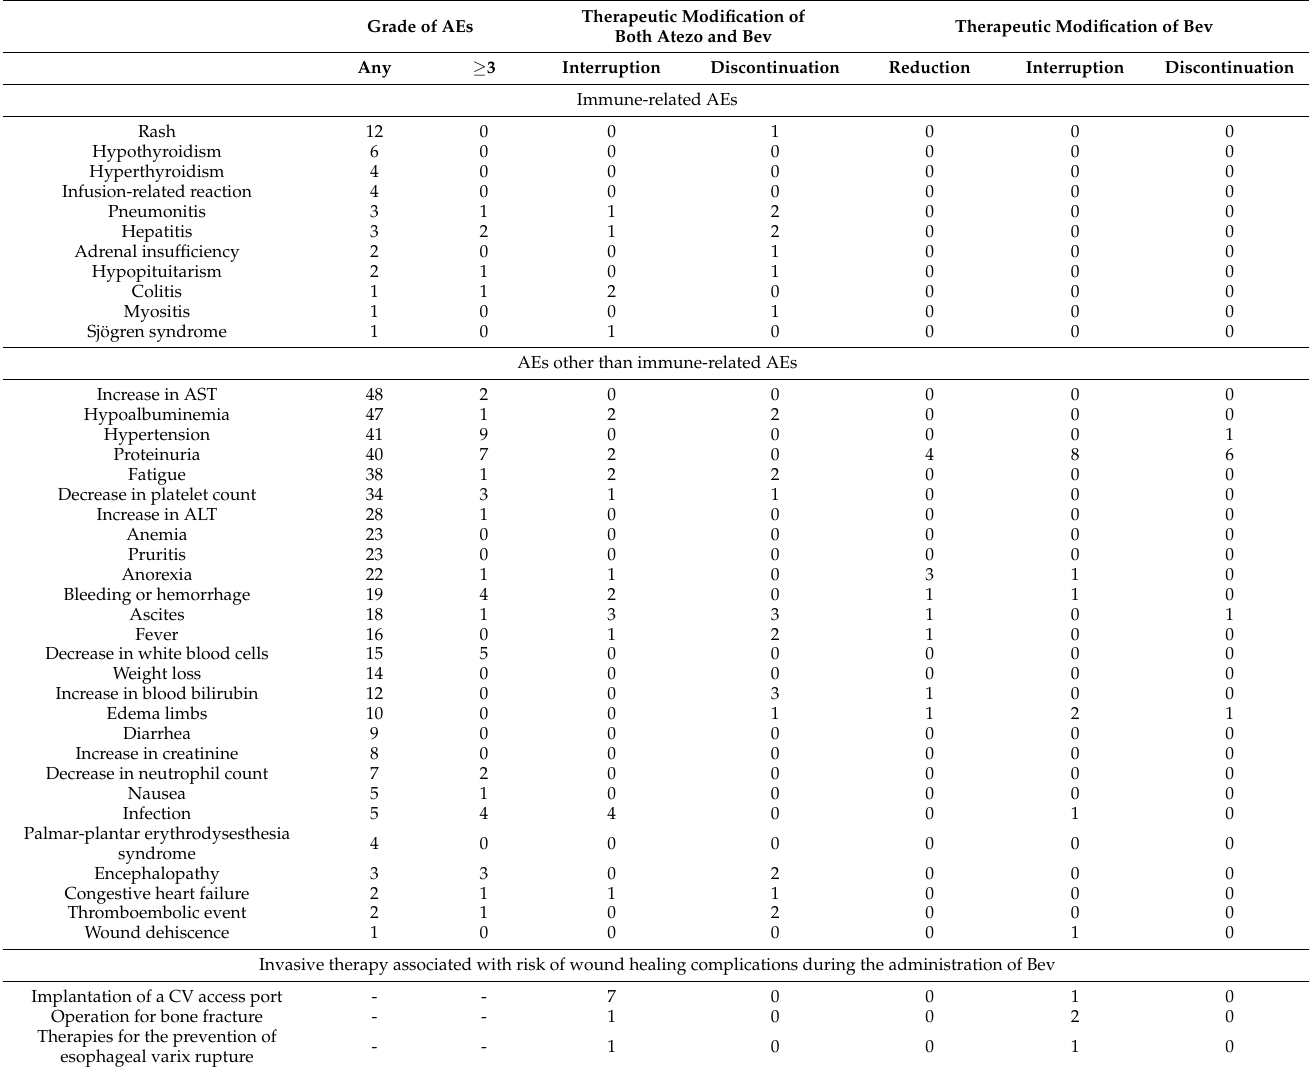
Table 3. AEs and events which caused therapeutic modifications of Atezo/Bev during time to progression ( n =